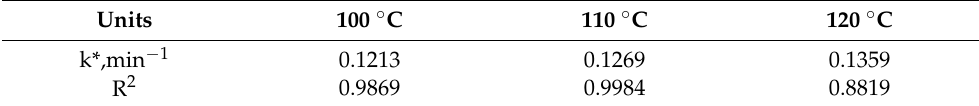
Table 7. Adjustment data for different reaction temperatures. Pseudo-first reaction